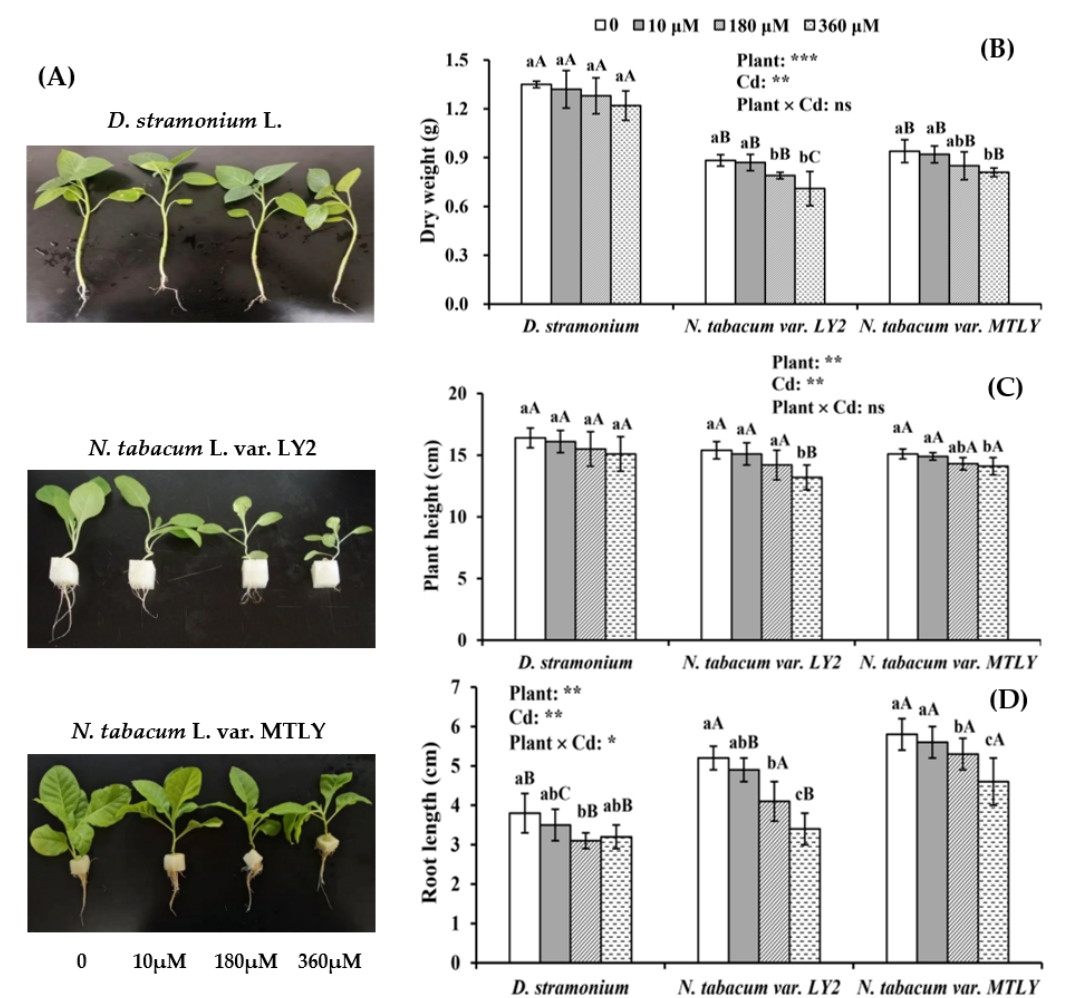
Figure 2. The growth traits of seedlings exposed to di ff erent Cd concentrations for 7 days under hydroponic conditions. ( A ) The phenotypic changes of D. stramonium , N. tabacum L. var. LY2 and N. tabacum L. var. MTLY. Dry weight ( B ), plant height ( C ) and root length ( D ). Values were expressed